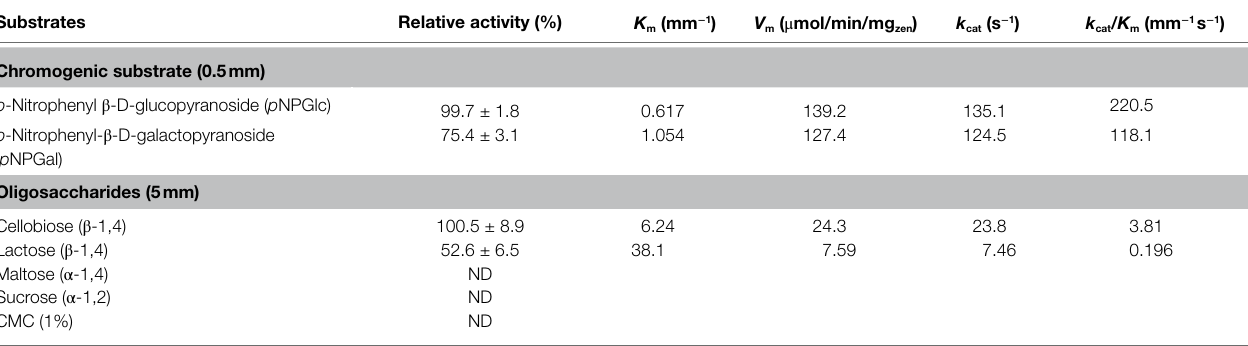
TABLE 2 | Effects of the β -glucosidase on different substrates. Substrates